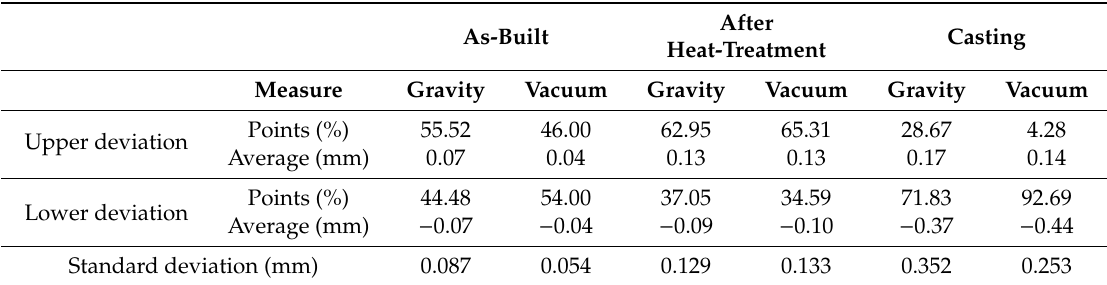
Table 4. Results of dimensions quality for moulds and parts obtained by